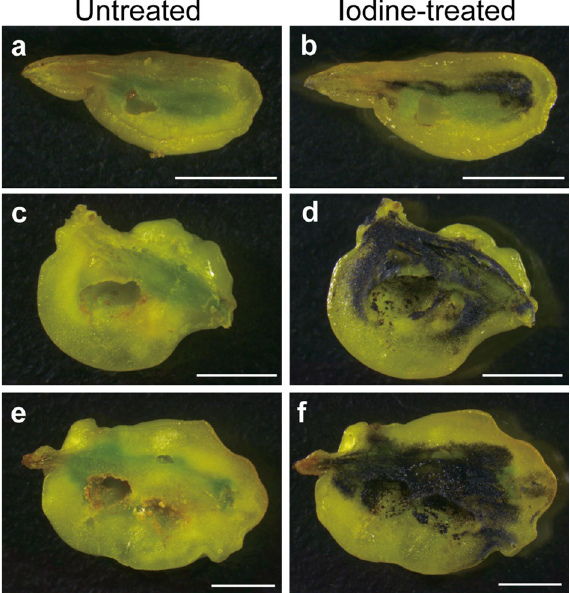
Figure 7. Distribution of starch in the gall. ( a , b ) Sagittal section of the early mid stage, ( c , d ) late mid stage, and ( e , f ) mature stage of the galls. In ( b , d , f ), starch was detected as blue-black colour upon staining with Lugol’s iodine solution. Bars, 5